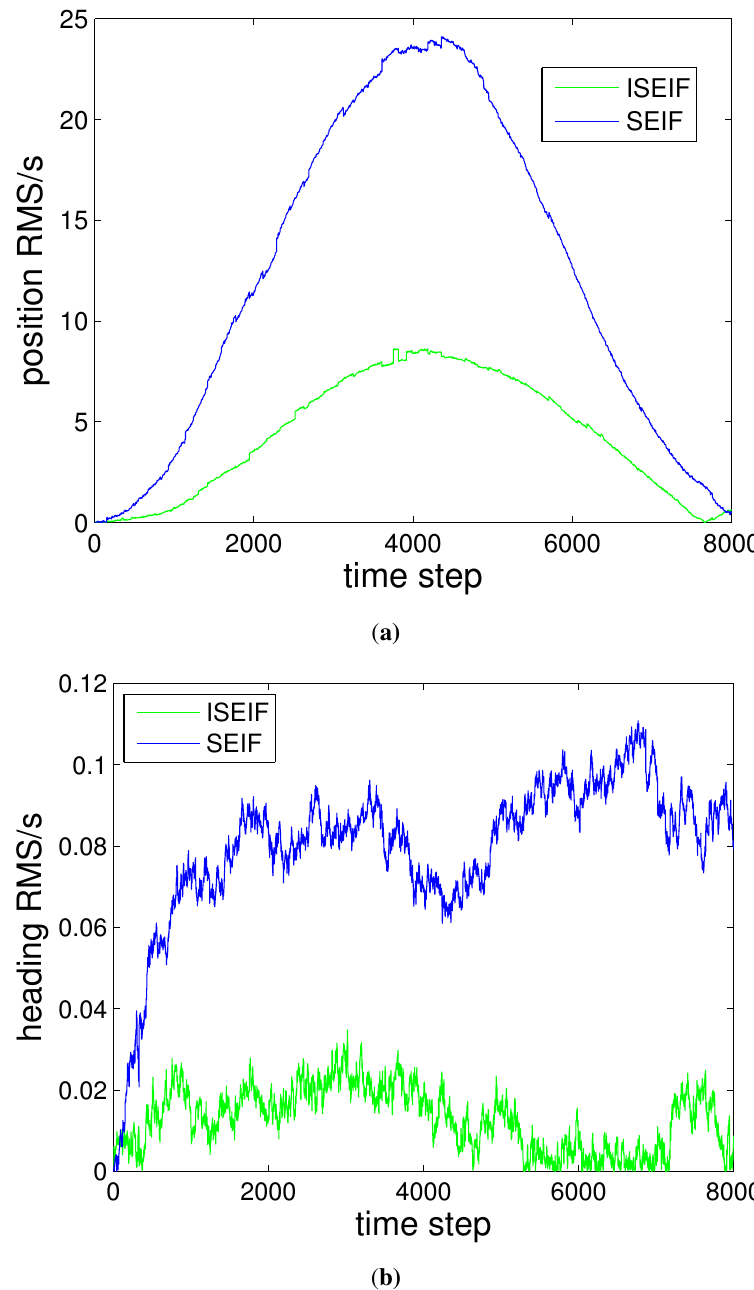
Figure 4. The RMS errors of positions and headings of SEIF ( a ) and ISEIF ( b ).